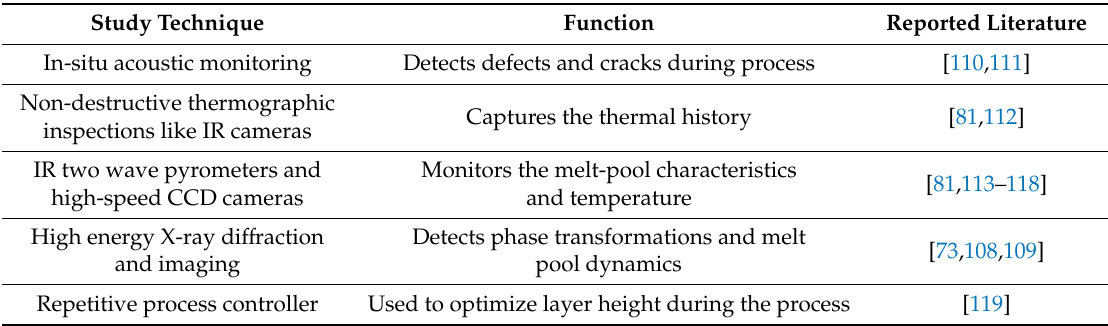
Table 4. Selected studies on DED process